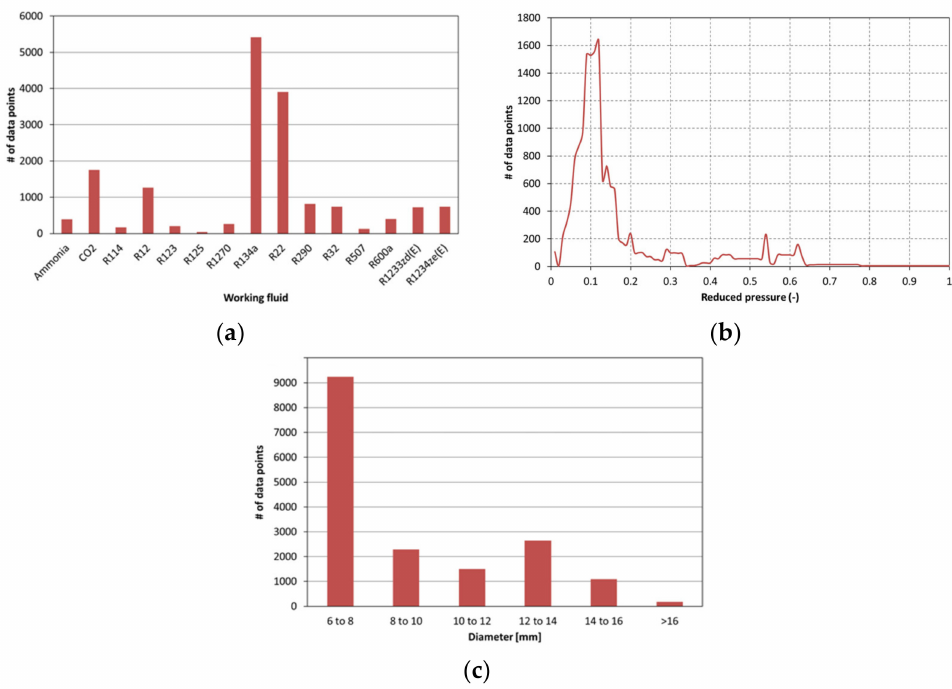
Figure 1. Distribution of the experimental flow boiling data for horizontal plain tubes having inner diameter larger than 6 mm from the literature between 1990–2021, ( a ) per working fluid, ( b ) per reduced pressure and ( c ) per inner tube diameter.